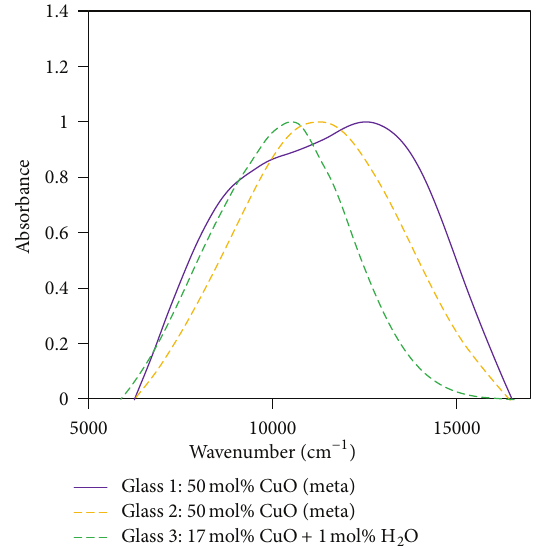
Figure 4: Absorbance spectra of the metaphosphate glasses 1 and 2 and the ultraphosphate glass